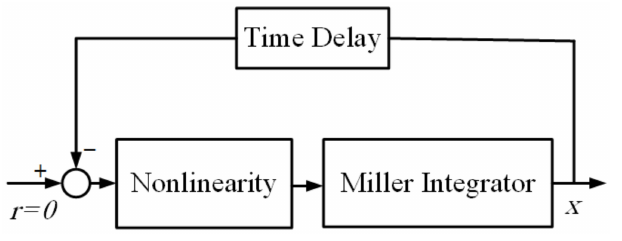
Figure 4. The Lur’e system’s